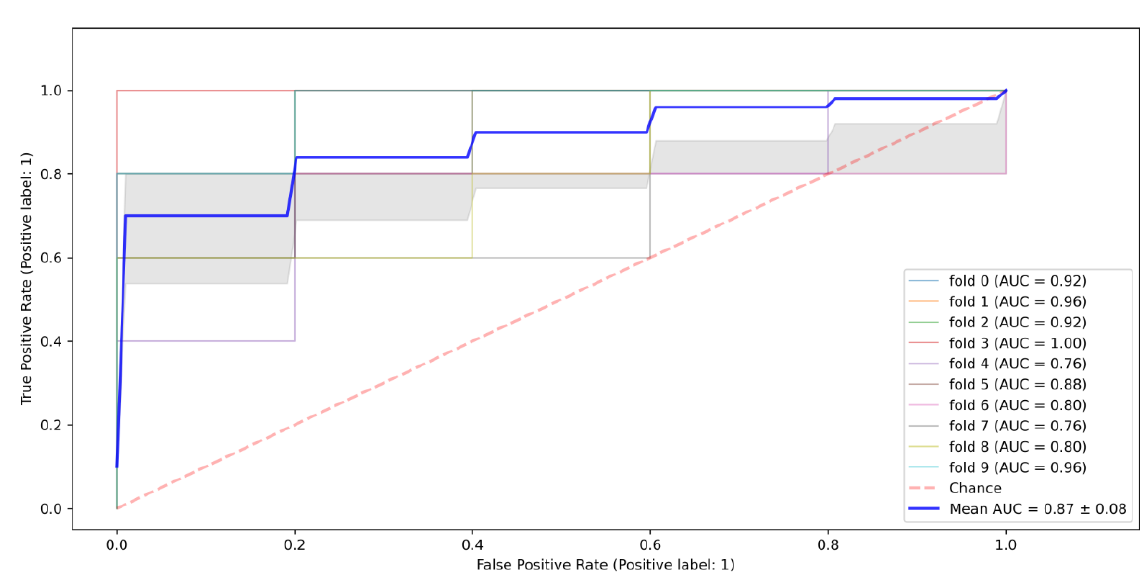
Figure 4. Naïve Bayes ROC algorithm ROC Curve. Figure 5. Support Vector Machine’s ROC